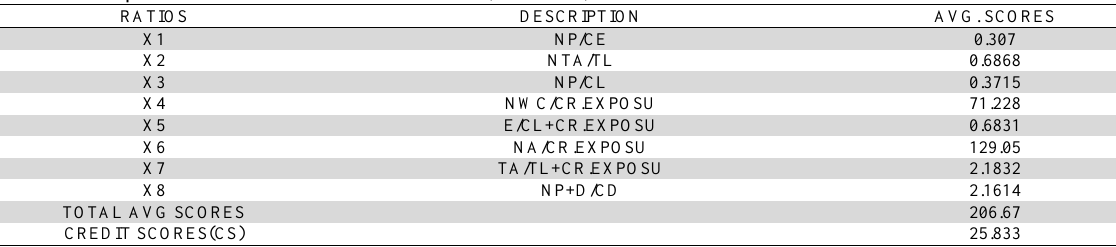
Risk Description Model – Ratio